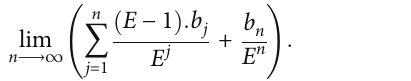
mial time and promotes the later primal dual method.